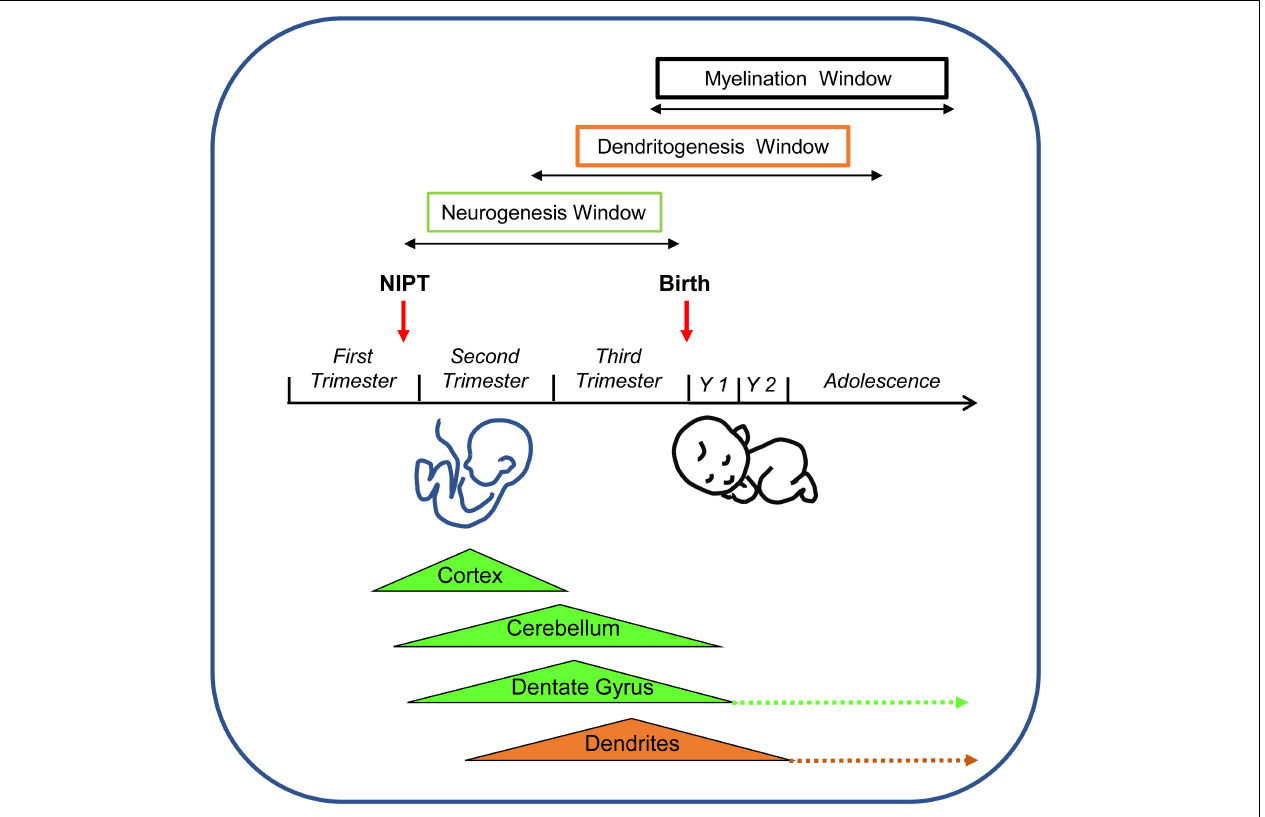
FIGURE 9 | Windows of opportunity for the improvement of neurogenesis, dendritogenesis, and myelination in DS. Note that the prenatal and postnatal timelines are not to scale. The time at which NIPT is generally performed is indicated. Abbreviations; NIPT, non-invasive prenatal testing; Y,